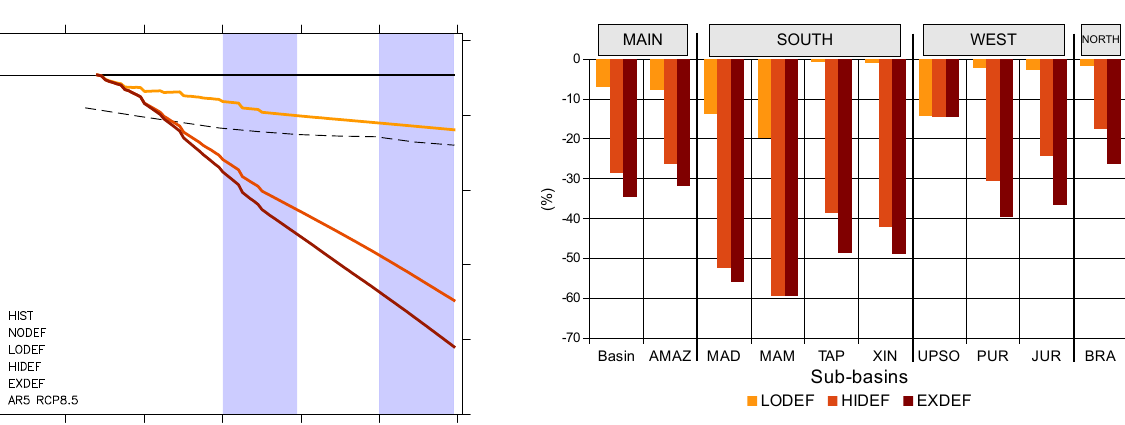
Figure 6. Forest area decrease (%) over the different catchments of the Amazon Basin between each of the three LCC scenarios in 2099 and the NODEF scenario in 2009 (the abbreviations of the catch- ments are indicated in Table